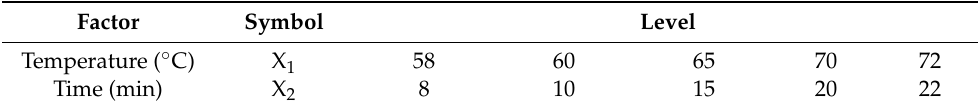
Table 2. Factors and their levels in the three points of central composite design for optimizing the smoking conditions of roasted